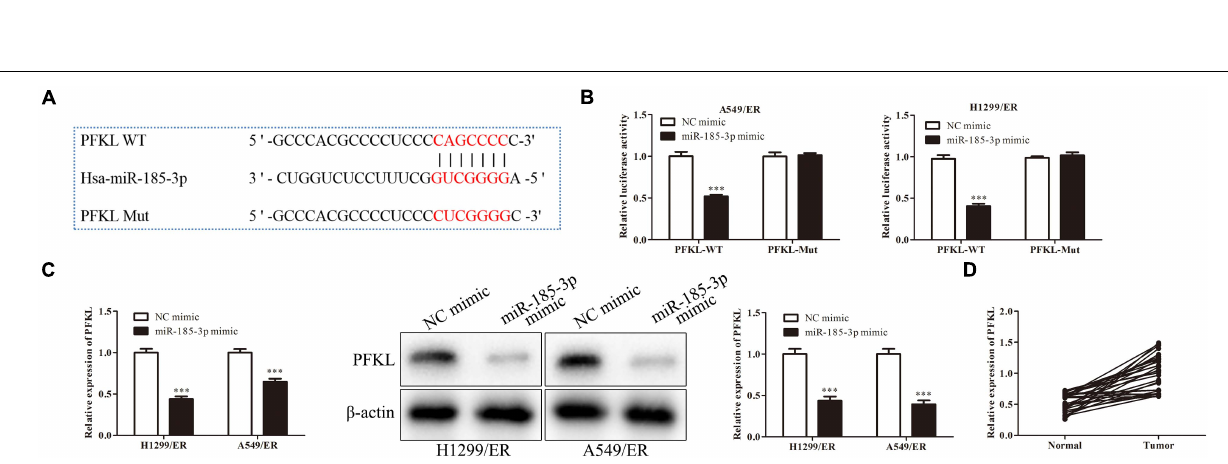
Frontiers in Cell and Developmental Biology |